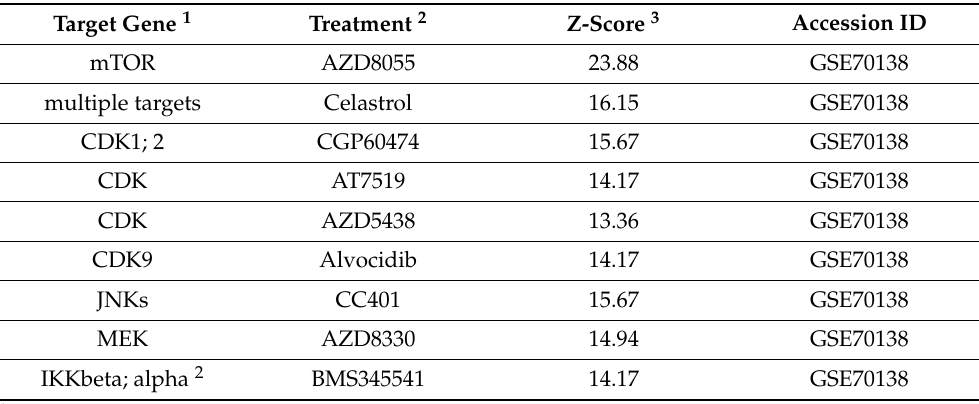
Table 5. IPA Analysis match for the 4-oxo DHA-induced expression profile in MDAMB468. Target Gene 1 Treatment 2 Z-Score 3 Accession ID mTOR AZD8055 23.88 GSE70138 multiple targets Celastrol 16.15 CDK1; 2